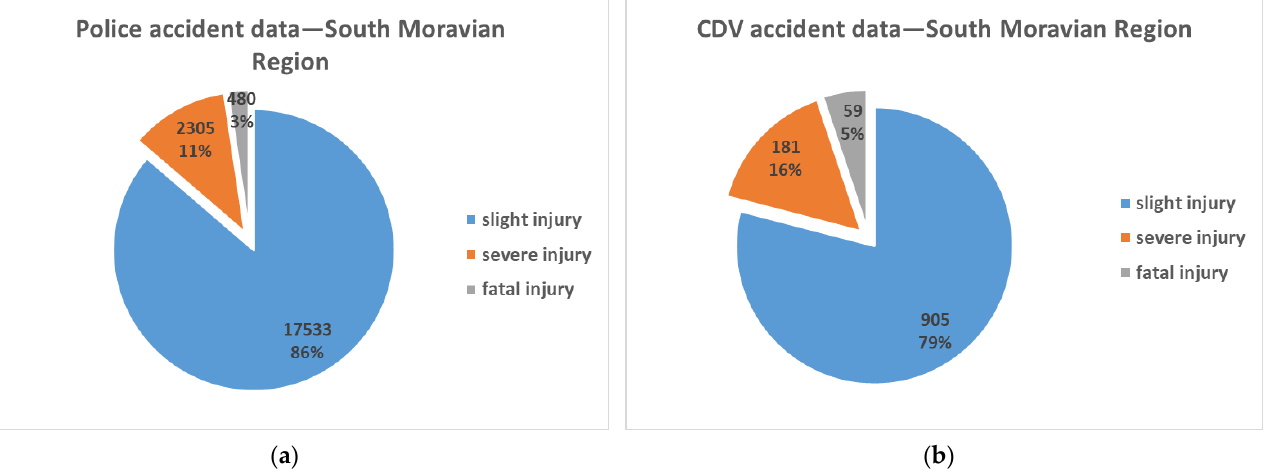
Figure 4. Comparison of police ( a ) and CDV data ( b ) accident severity in the South Moravian Region (2011–2019).